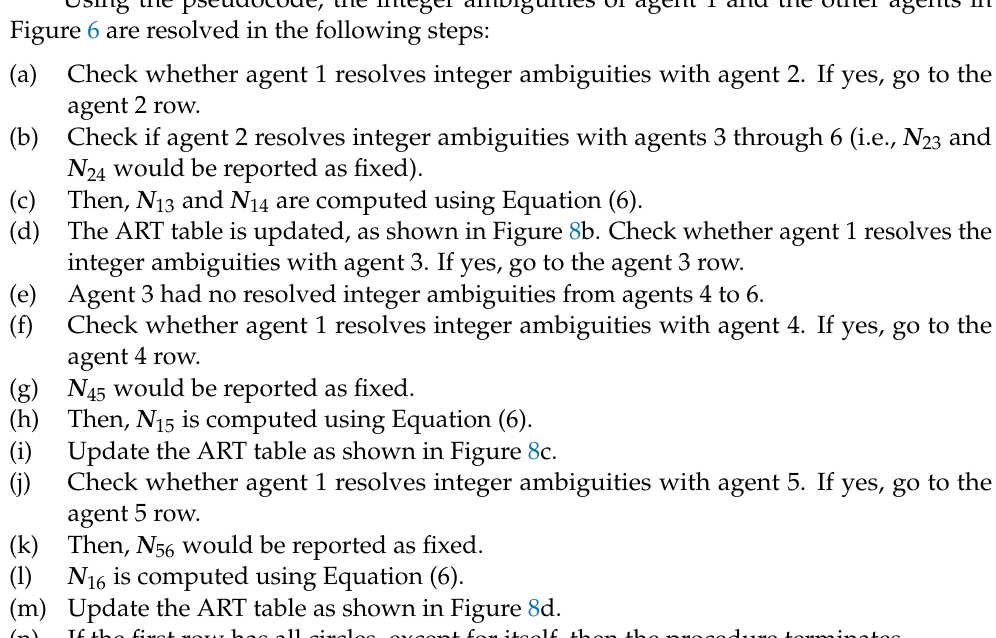
Figure 7. Pseudocode for the integer ART